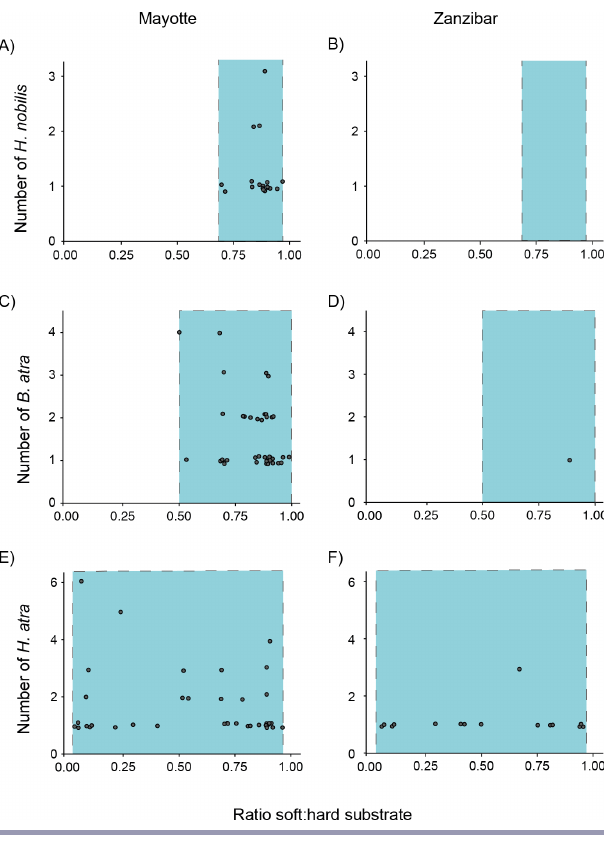
Fig. 2 . Comparison of transects from Mayotte (left panels) and Zanzibar (right panels). Shaded blue areas denote transect types (ratio soft:hard substrate) where each species was found in Mayotte, and the assumed suitable habitat for the species at both sites. Number of transects (n) comprising each panel: A = 70, B = 113, C = 74, D = 123, E = 108, and F =